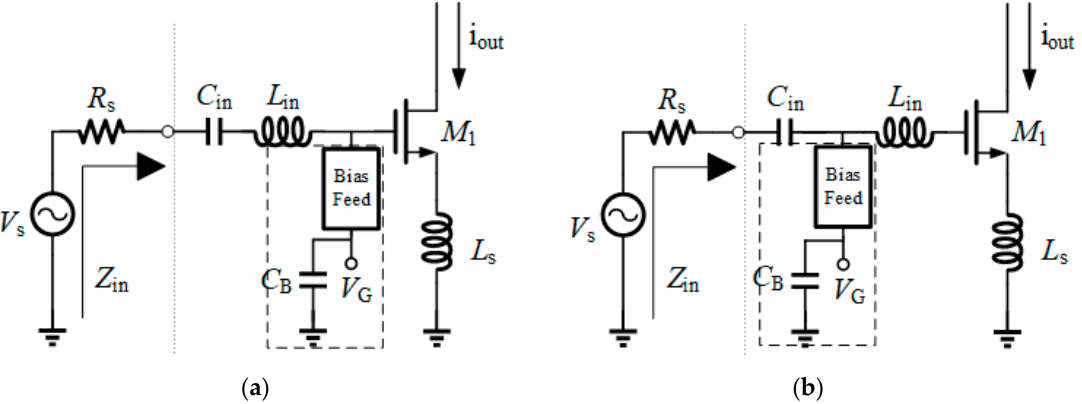
Figure 2. ( a ) Input schematic diagram with bias circuit postposition after L in ; ( b ) input schematic diagram with bias circuit proposition before L in .